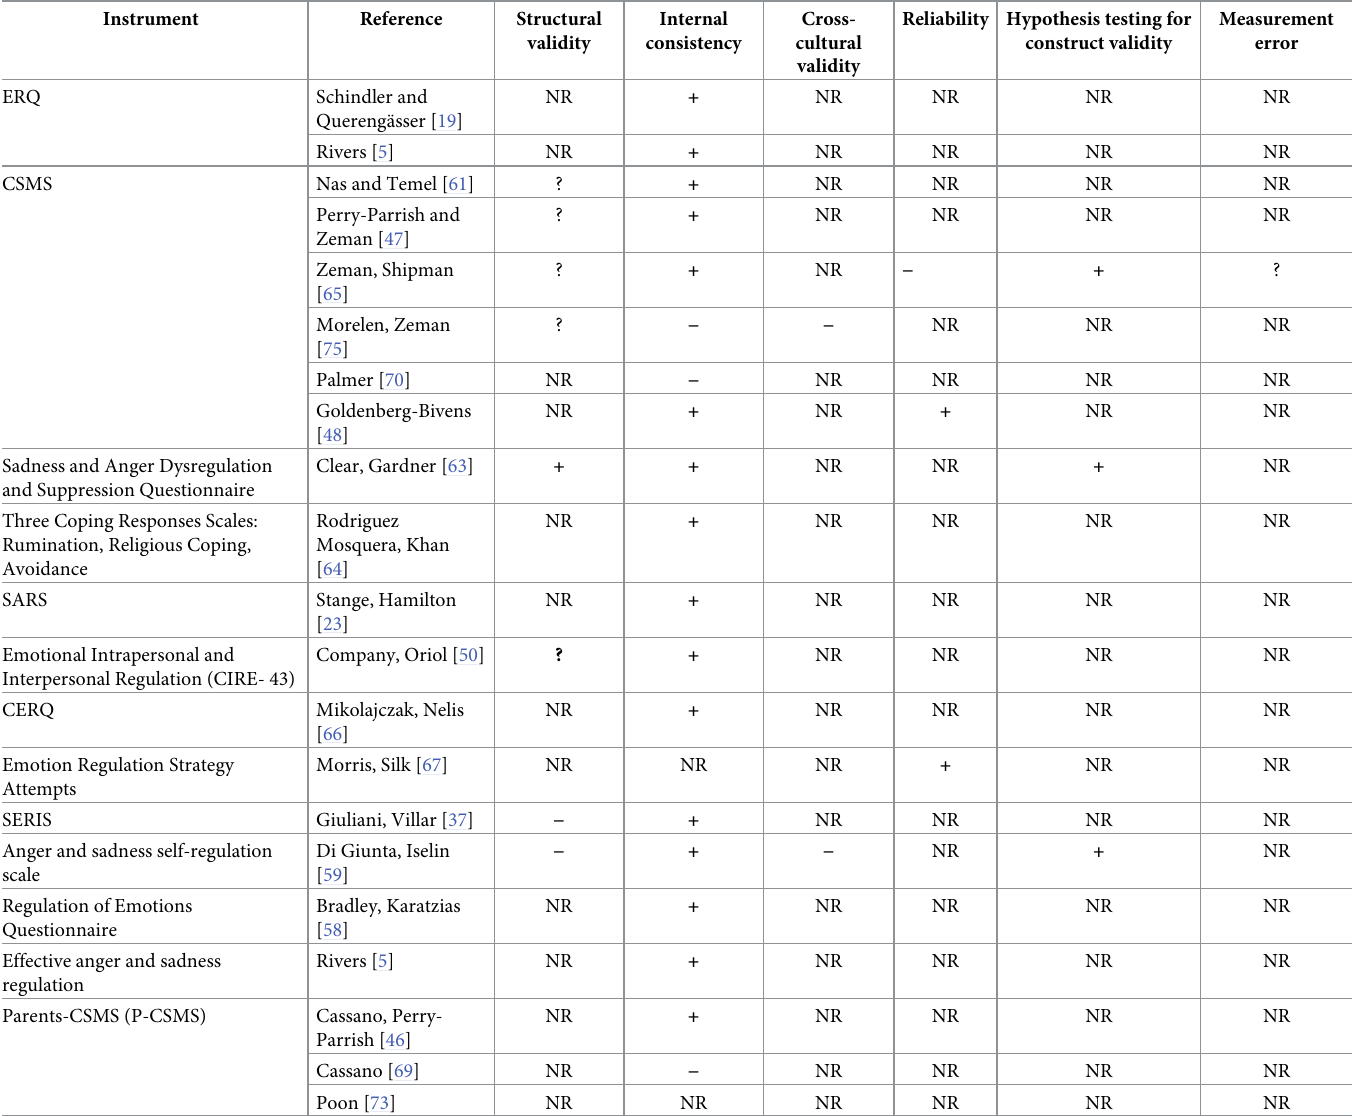
Table 4. Quality of psychometric properties per